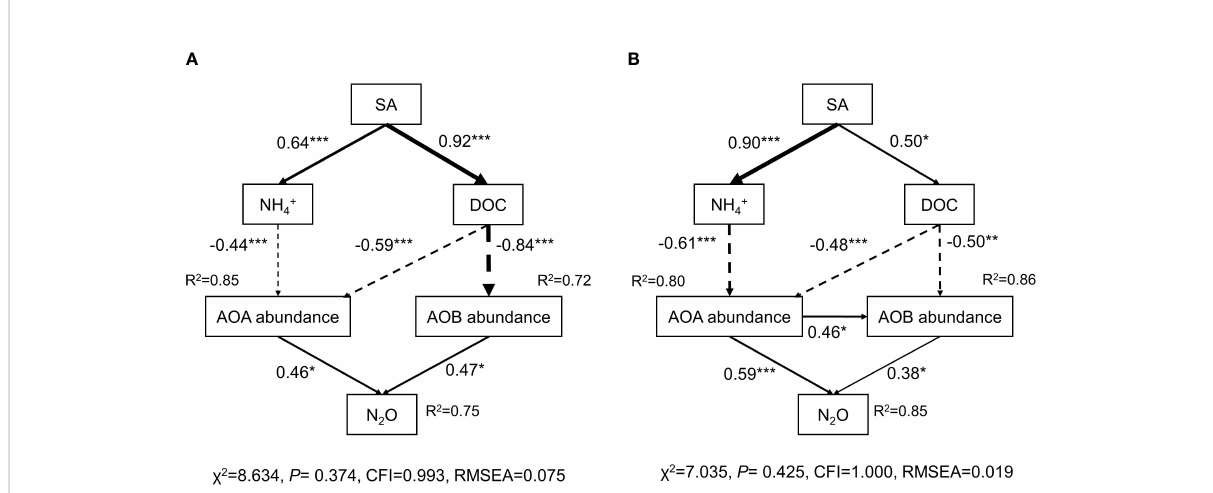
FIGURE 5 The structural equation model (SEM) explaining the mechanisms driving N 2 O emission as SA induces changes in soil properties and in fl uences ammonia oxidizer communities in paddy and red soils. The arrow width indicates the strength of the standardized path coef fi cients. The solid line represents positive effects and the dashed line represents negative effects. Numbers on the arrows indicate signi fi cant standardized path coef fi cients (* p < 0.05; ** p < 0.01; *** p < 0.001). R 2 indicates the proportion of the variables explained by the